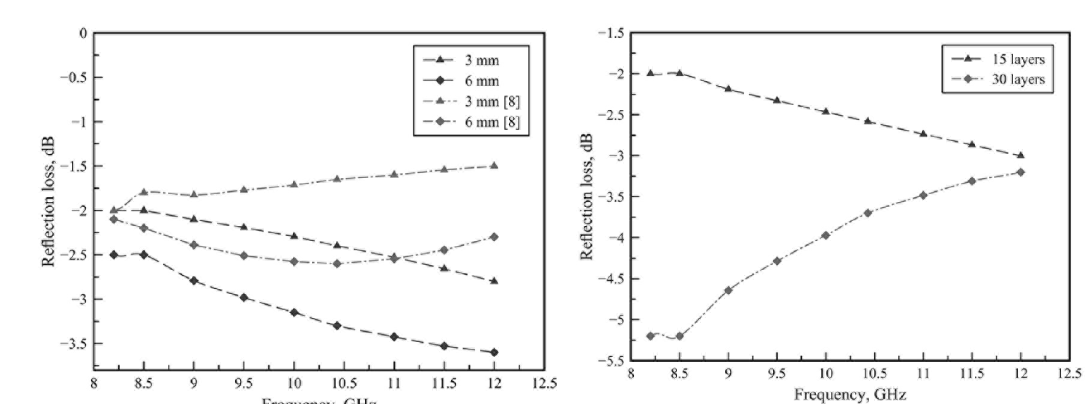
O arrays particles-paraffin wax sample versus frequency and layer of flat 3 4